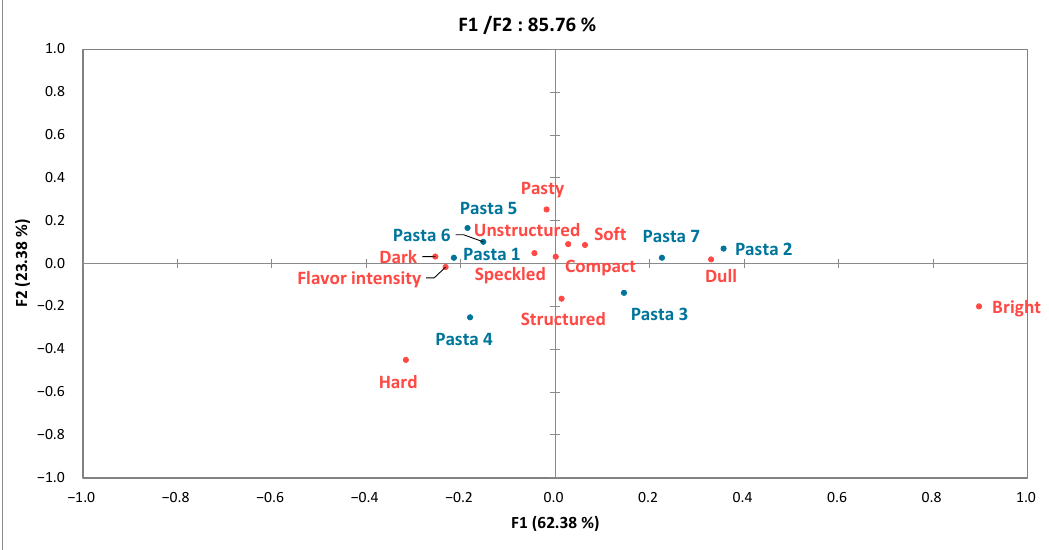
Figure 4. Correspondence analysis of the contingency table obtained from the Pivot analysis.